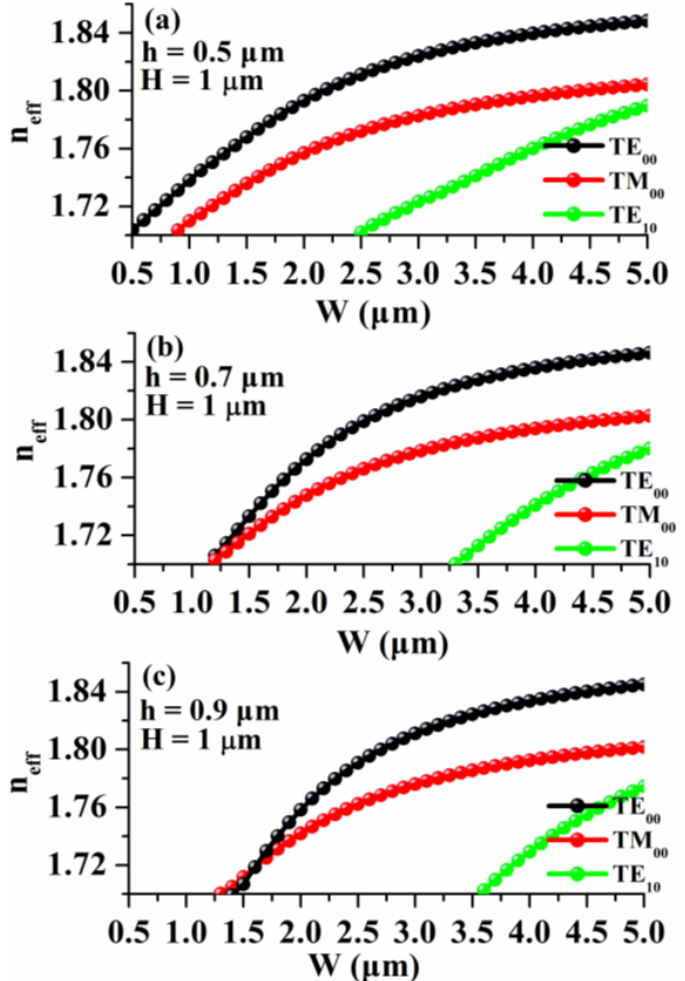
Figure 2. Effective refractive indices n eff of the TE 00 , TM 00 and TE 10 modes as a function of rib width W for three different rib heights: ( a ) h = 0.5 µ m, ( b ) h = 0.7 µ m and ( c ) h = 0.9 µ m. Moreover, the rib height h considerably affects the waveguiding characteristics. The increase in etching depth h is equivalent to the decrease in rib width W. As a result, the mode index decreases as the rib height h increases. The observation may also be explained on the basis of the slab waveguide thickness effect on the mode index. For a slab waveguide, the mode index increases with its thickness. The increase in the rib thickness h is equivalent to the decrease in slab thickness and, thereby, of the mode index. The considerable rib height effect on the mode index leads to a definite effect on the single-mode condition. One can see from Figure 2a–c that the cutoff rib width of the TE 10 mode is similar—2.5, 3.25 and 3.5 µ m for the rib height h = 0.5, 0.7 and 0.9 µ m, respectively. The n eff curves at the signal and pump wavelengths are provided in Figure 3a–f. It shows that the cutoff widths of the TE 00 and TM 00 modes of the pump light and signal light are less than 0.5 µ m and that the cutoff width of the TE 10 mode of the pump light and signal light is around 1.5 µ m. The influences of W and h on n eff are the same as that mentioned in Figure